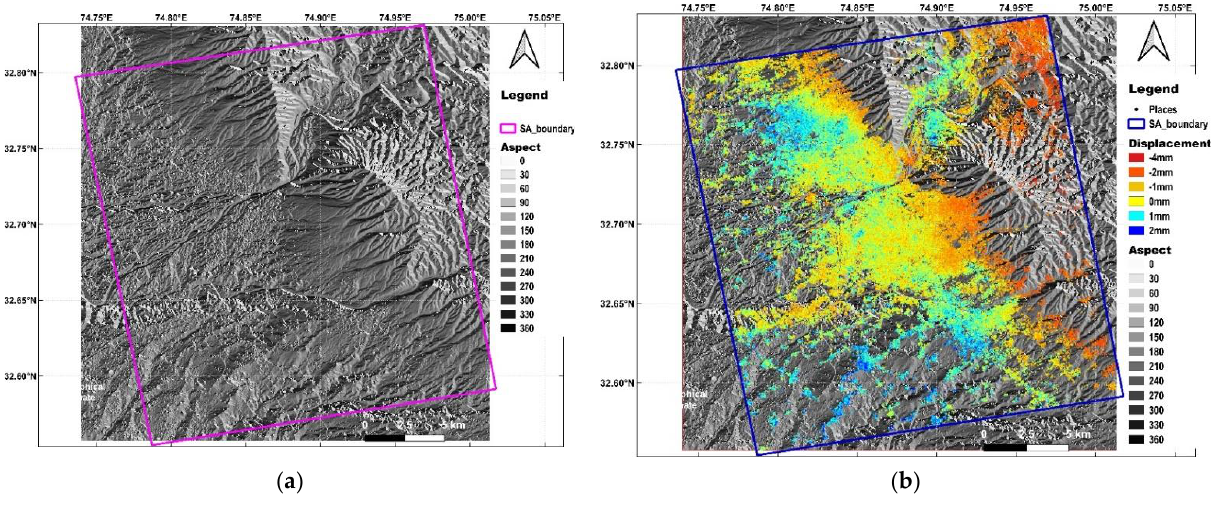
Figure 11. ( a ) Slope Aspect of the study area in degrees determined from the Copernicus 30 m DEM, ( b ) Overlay of the retrieved LOS displacement on ( a ).